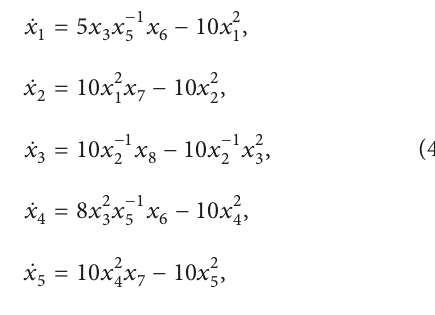
Figure 3: (3 genes) simulation results of Case 8 in Table 1.